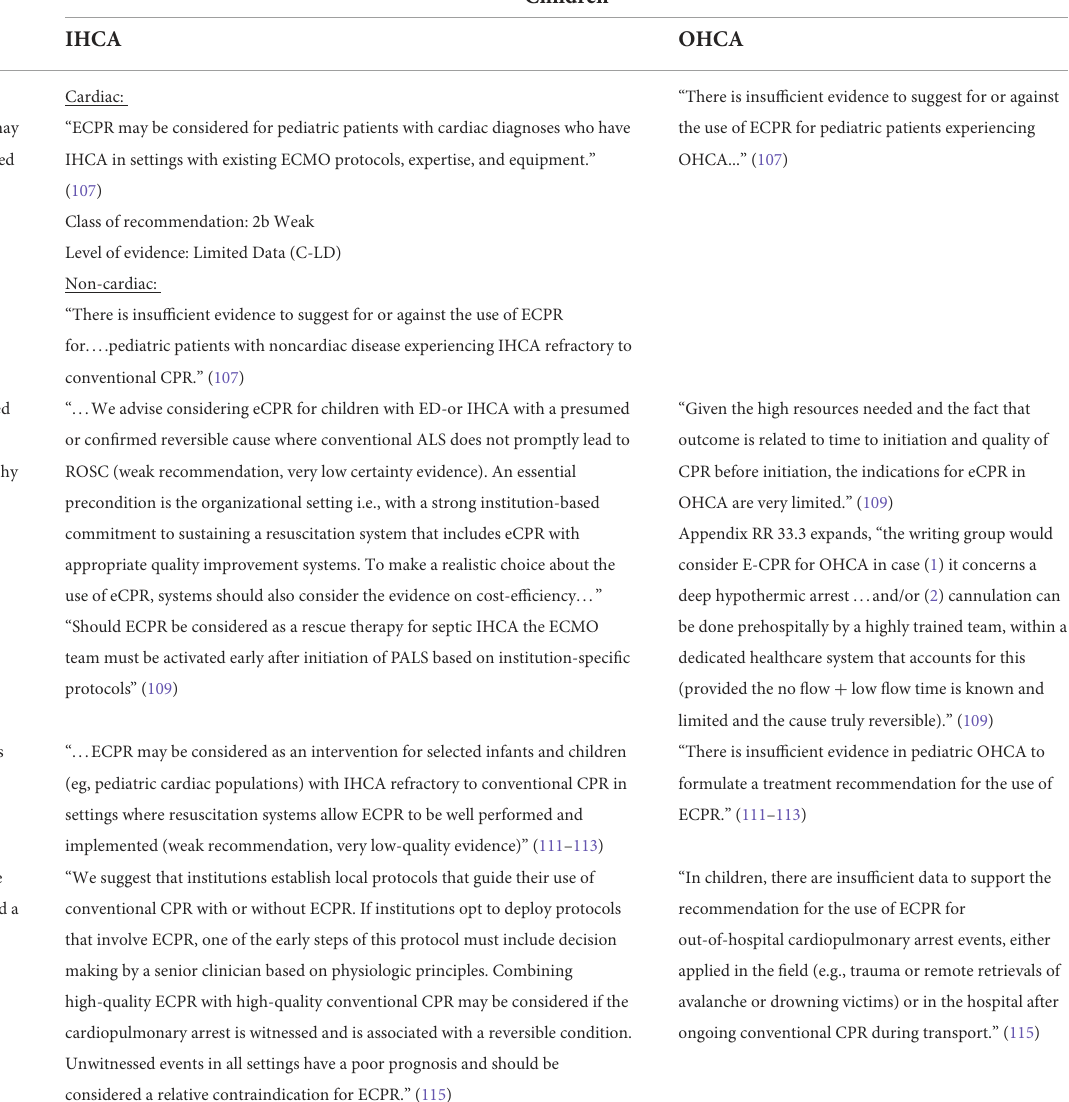
TABLE 1 Published society guidelines on the use of ECPR in adults and